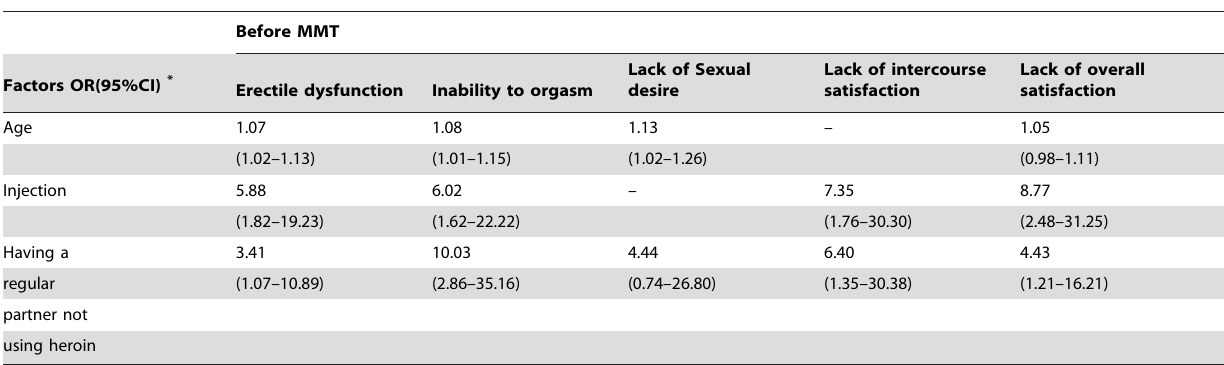
Table 4. Multivariate analysis of factors associated with sexual dysfunction before MMT.